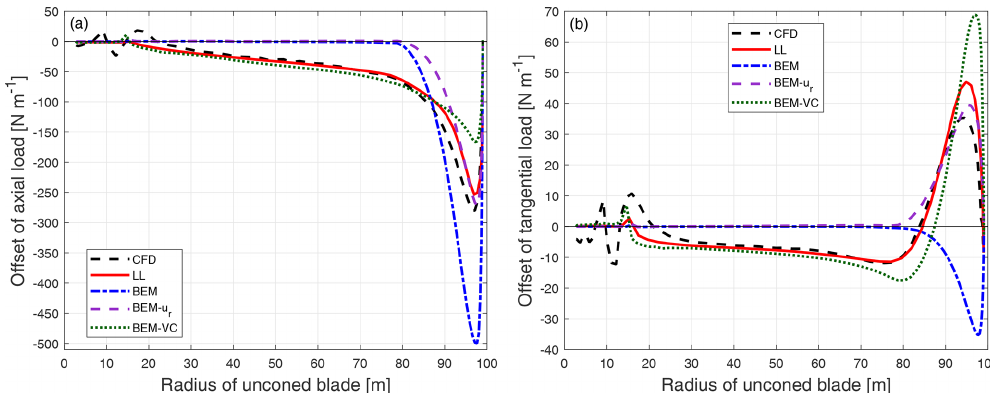
Figure B6. Comparison of the difference of the axial load (a) and tangential load (b) of the dihedral blade W-4 with 15 ◦ of cone upwind compared to the baseline blade with the same cone calculated from different aerodynamic models.